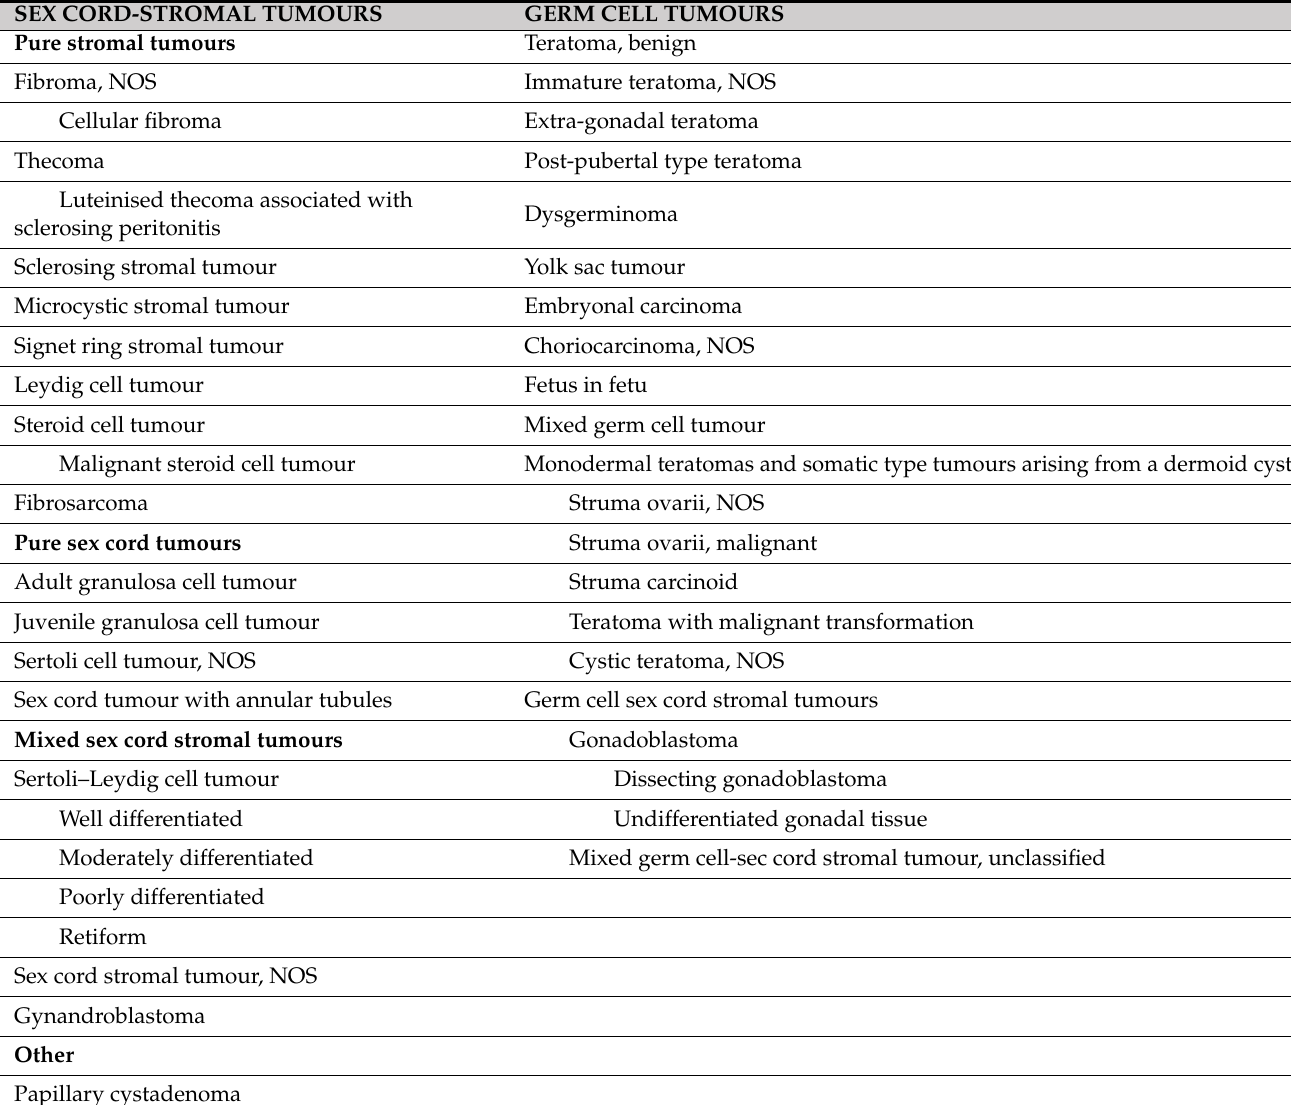
Table 1. WHO (World Health Organisation) 2020 classification of germ cell tumours (GCTs) and sex cord-stromal tumours